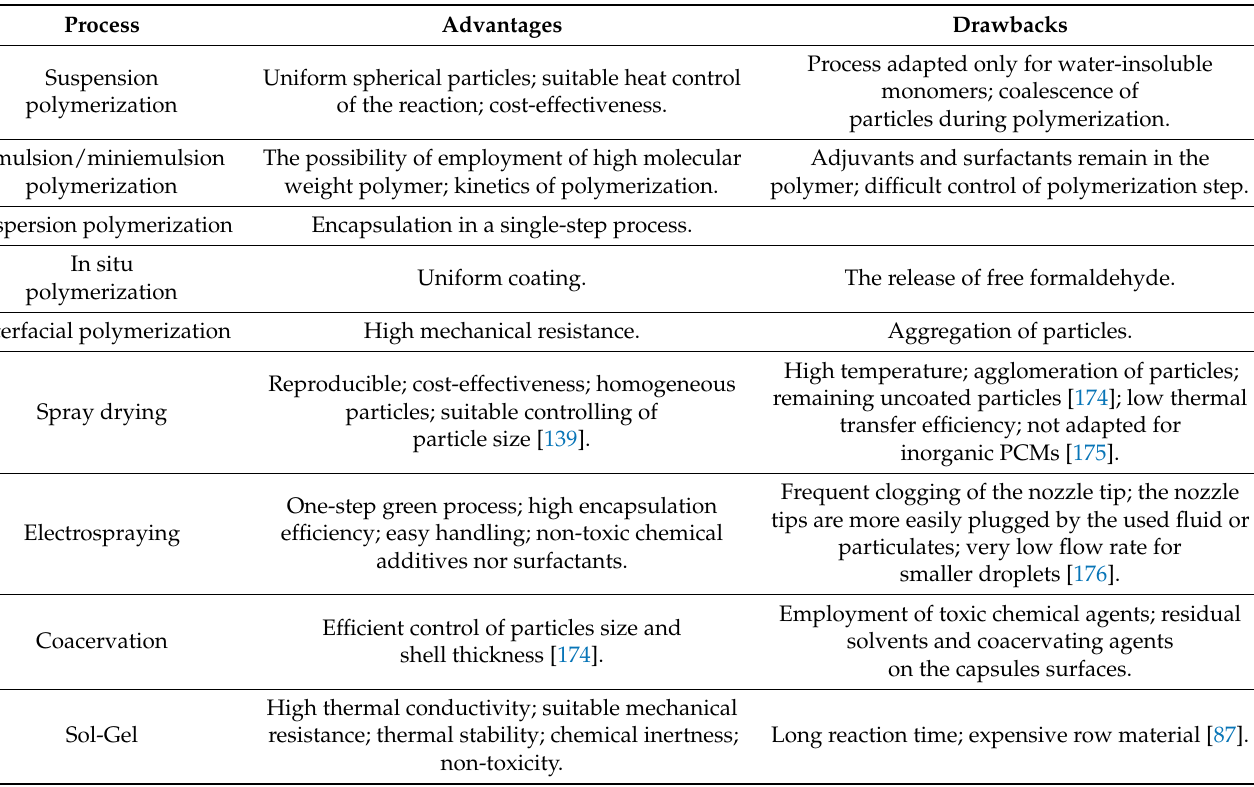
Table 4. Comparison of different encapsulation